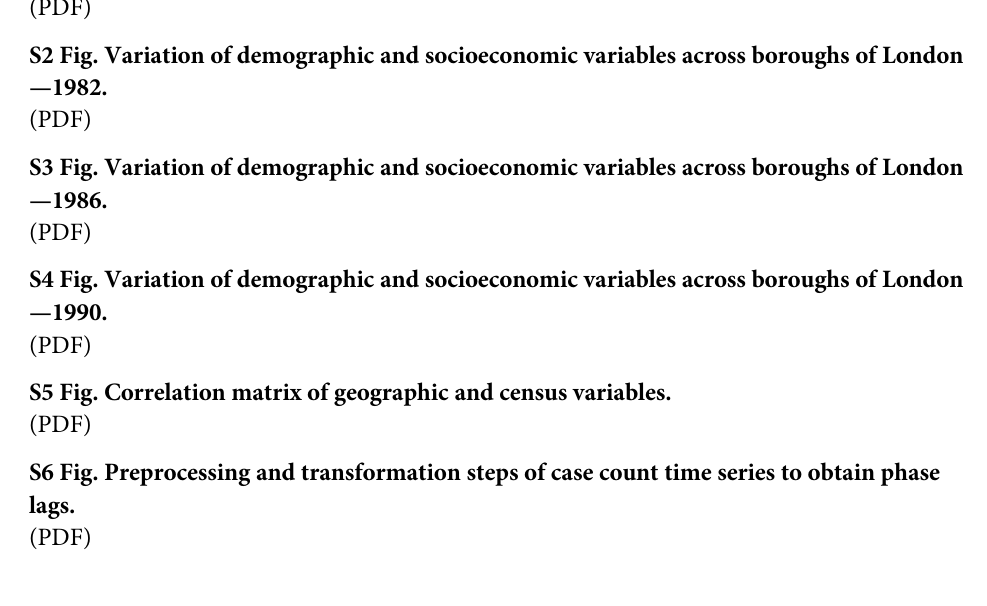
S1 Fig. Interpolation of demographic and socioeconomic variables from decennial cen- suses. S2 Fig. Variation of demographic and socioeconomic variables across boroughs of London